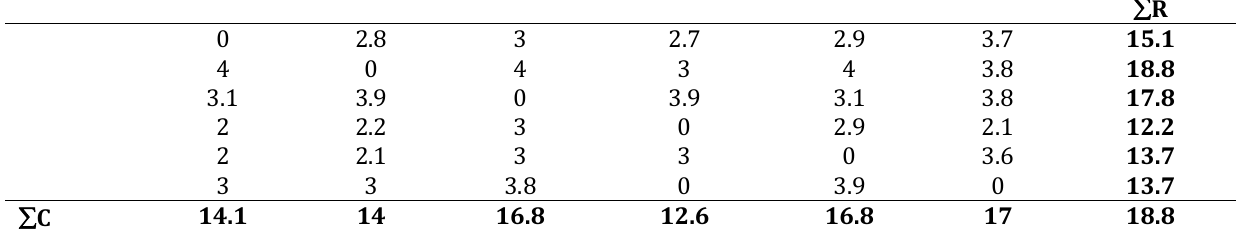
Table 3: Overall Fuzzy Direct Relationship